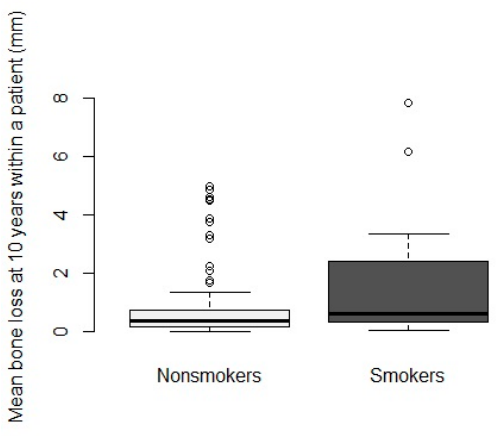
Figure 5. Boxplot reporting on mean peri-implant bone loss within each patient, comparing smokers and non-smokers after at least 10 years.